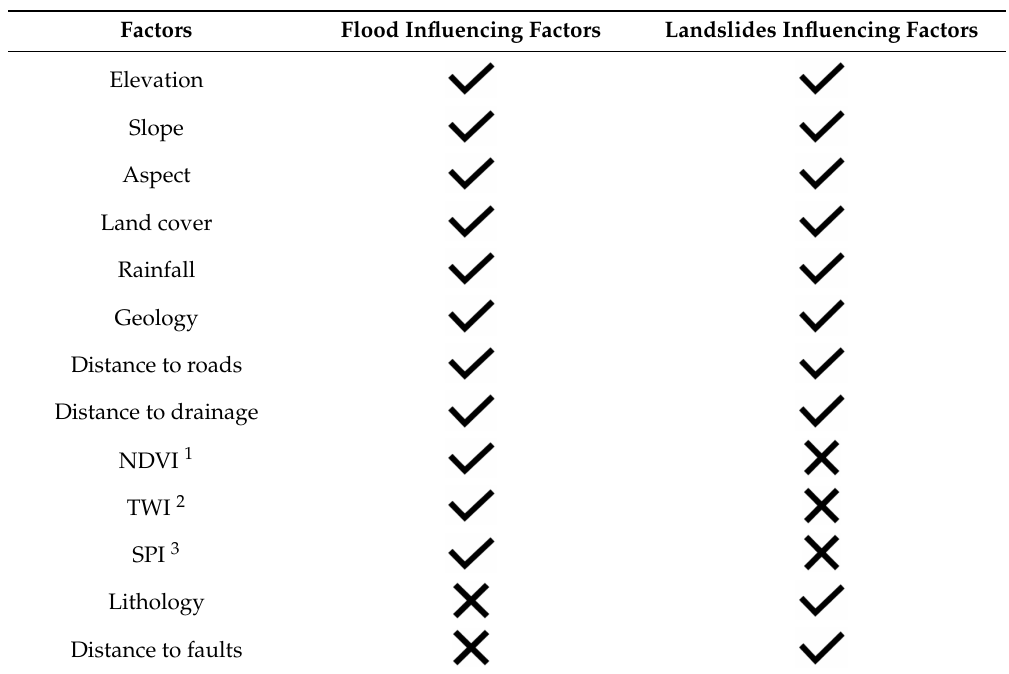
Table 1. Influencing factors for flood and landslides selected for the State of